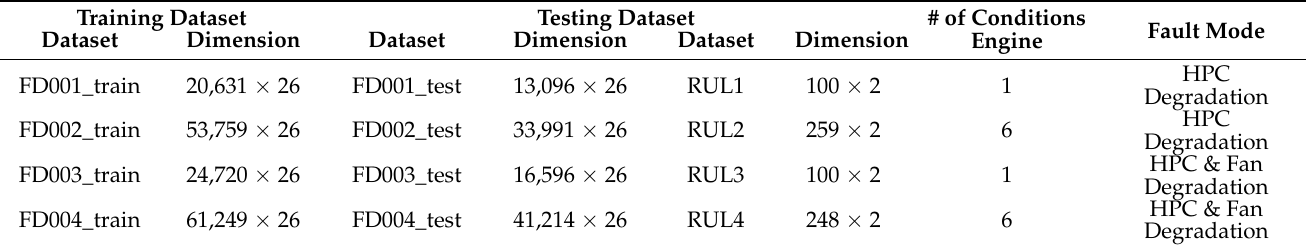
Table 1. Datasets.